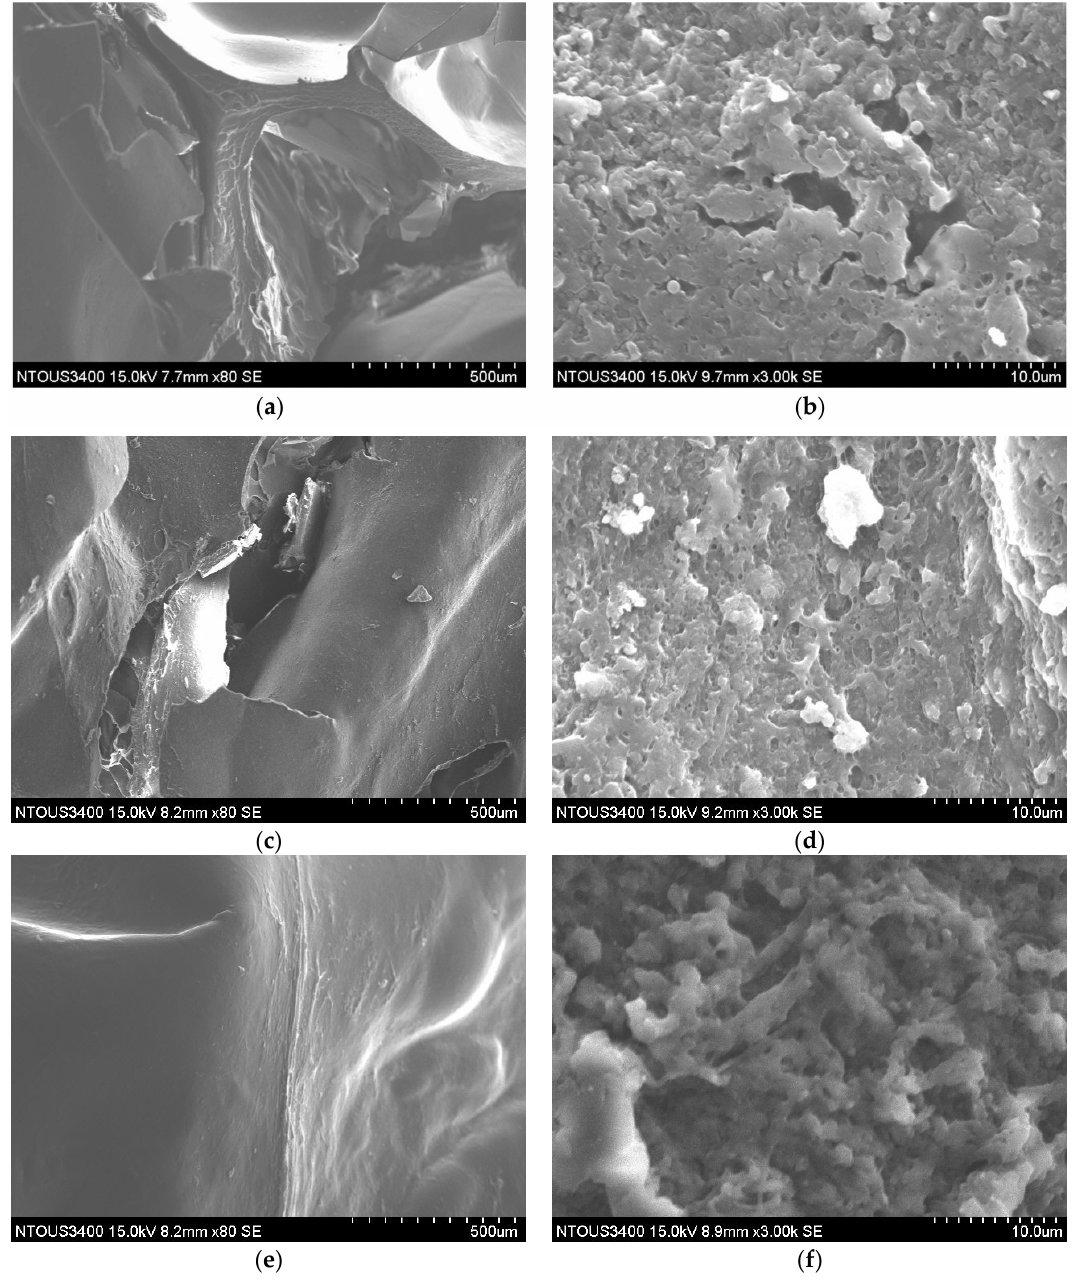
Figure 4. Effect of the raw pork skin thickness in the microstructure of fried pork rinds via scanning electron microscopic analysis (500 μ m & 10 μ m scale); 0.2 cm dried pork skin ( a ),( b ), 0.3 cm dried pork skin ( c ),( d ), 0.4 cm dried pork skin ( e ),( f ).